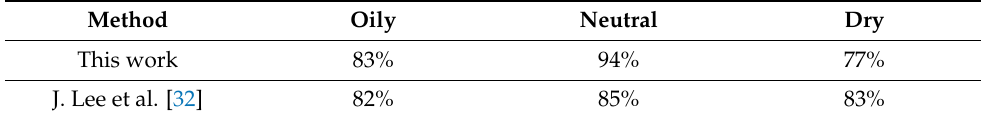
Table 4. Accuracy of skin type classification.